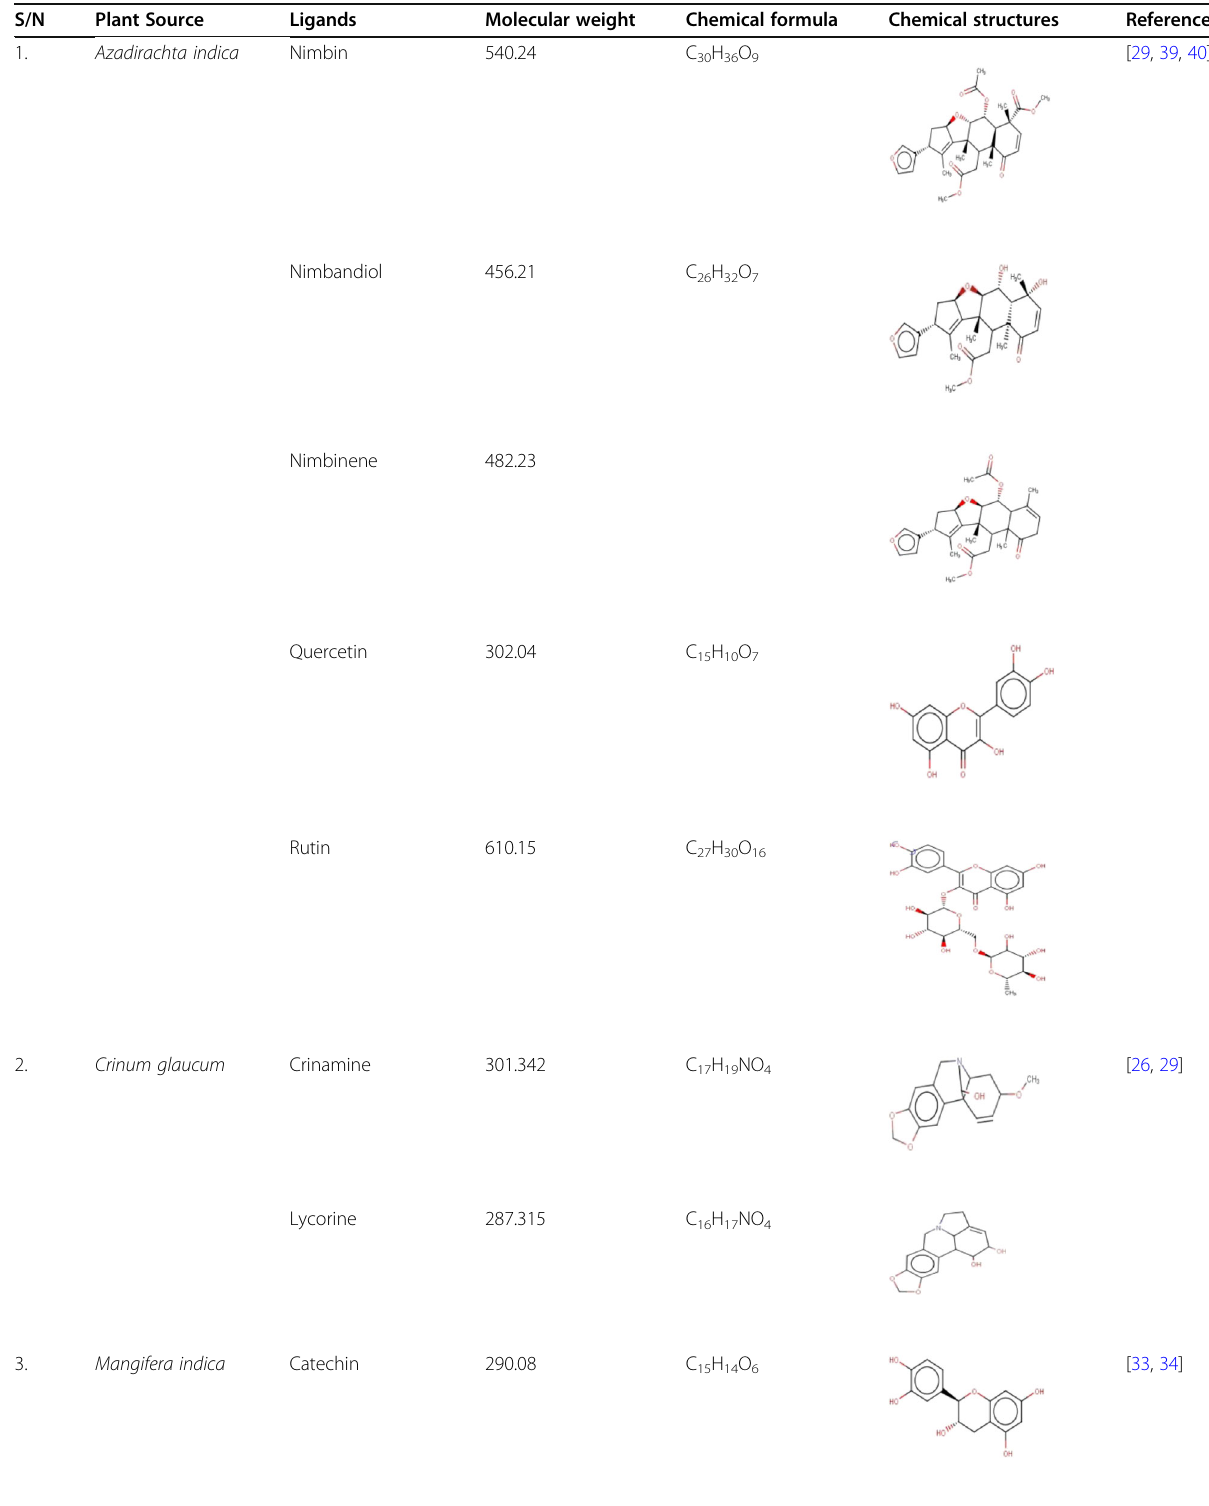
Table 1 Chemical Structure of bioactive compounds in A . indica , C . glaucum , and M . indica